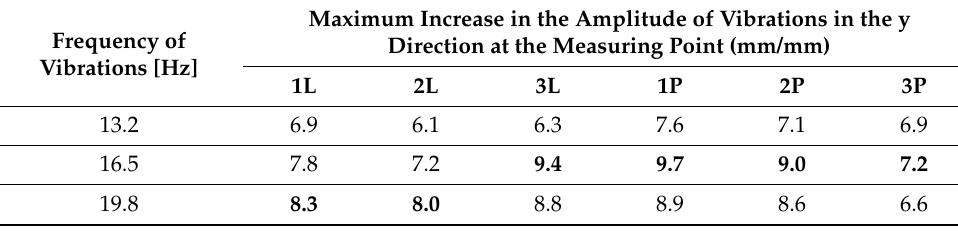
Table 2. Maximum multiples of vibration amplitudes in the y